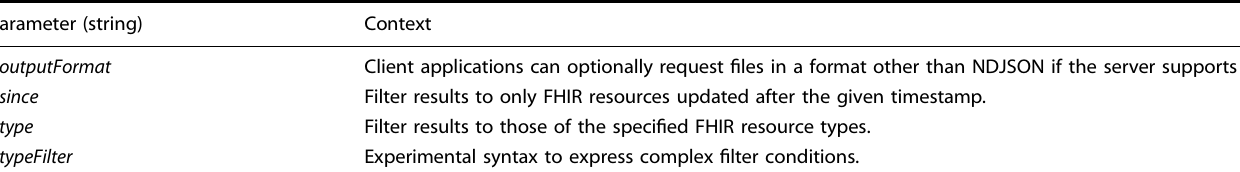
Table 1. Key query parameters to fi ne-tune bulk FHIR fi les generated from the kickoff request.